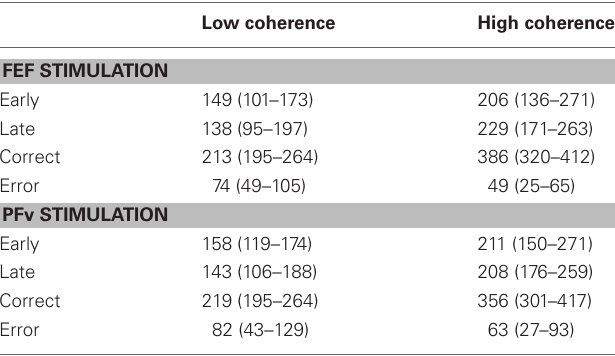
Table 1 | Number of trials used for TMS-EP analysis (mean and